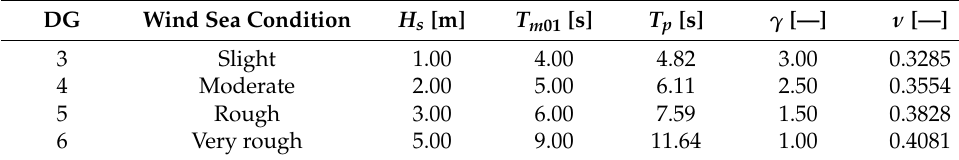
Table 1. Selected sea state conditions—wind sea.